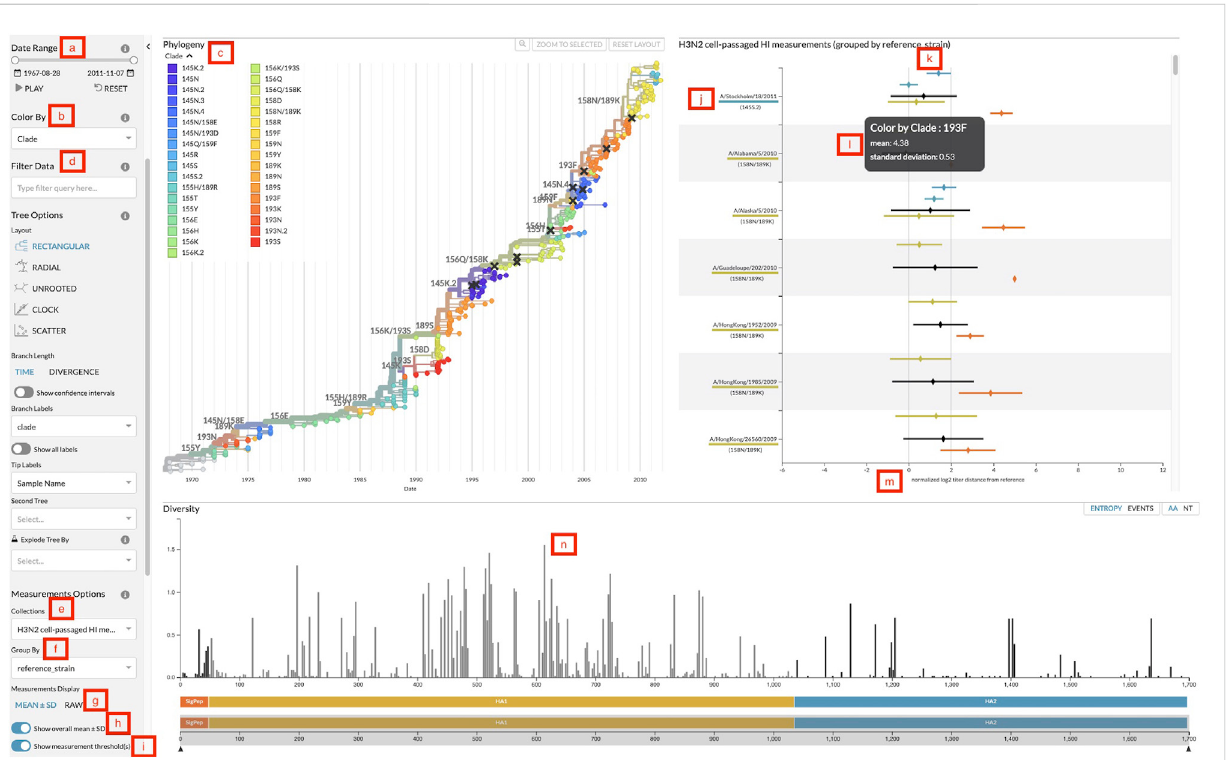
FIGURE 2 Screenshot of Auspice with thesidebar controls, thephylogenetic tree panel, the measurements panel, and the diversity panel. (A) Daterange slider to fi lter both tree and measurements by the test virus sample date. (B) Color-by dropdown to change the attribute to use for coloring the tree and measurements. (C) Legendforcolorsandtheircorrespondingvalueslinkedtovirusesinthetreeandmeasurements. (D) Data fi ltersearchbarto fi ltertree and measurements data by speci fi c attributes. (E) Measurements collection dropdown to change the collection of measurements displayed. (F) Measurements group by dropdown to change the grouping of measurements data. (G) Toggle to change measurements display between mean with standard deviation and individual raw measurements. (H) Toggle to display or hide the overall mean and standard deviation for each group. (I) Toggle to display or hide the threshold lines. (J) Grouping label for each group of measurements. Labels appear in descending order by the number of measurementsinthatgroup(default),bythecustomorderde fi nedinacon fi guration fi lepassedtoaugurmeasurementsexport,orintheordertheyhave been selected by a user fi lter. This particular view uses reference viruses that are also present in the tree so the label includes the virus ’ s corresponding colorandcolor-byvalue. (K) Thethresholdlinesfortitermeasurementstoindicatetwothresholds:antigenicallyidenticalvirusesatx=0andantigenically distinct viruses at x = 2. (L) The tooltip that displays more details for the hovered measurement. This particular view hovers over a mean and standard deviation. (M) The x -axis of the measurements plot shows the range of measurement values in this collection. (N) Clicking on a bar in the diversity panel updates the tree and measurements to color by genotypes at that